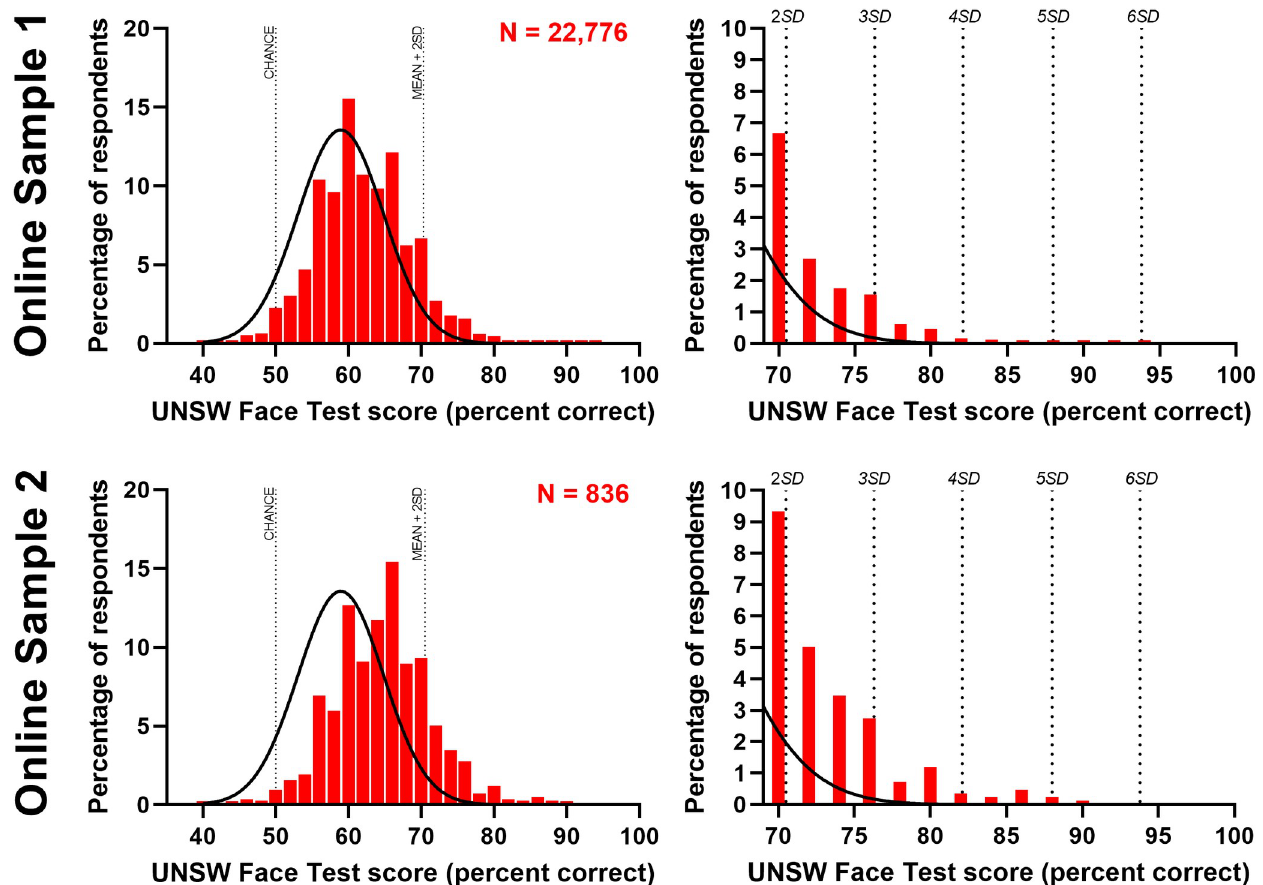
Fig 4. Distribution of accuracy in online samples. Left: Accuracy distribution of Online Sample 1 (top) and Online Sample 2 (bottom) compared to the normative accuracy distribution (black line). Right: Sample of distribution above the super-recognition threshold (2 SDs above the mean). The long tail of the distribution shows that the UNSW Face Test is sensitive to differences in performance up to 6 SD above the mean.